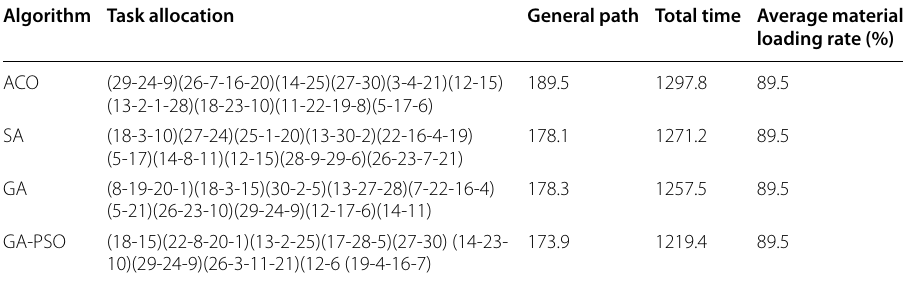
Table 5 Details of the optimal solutions of the third experiment Algorithm Task